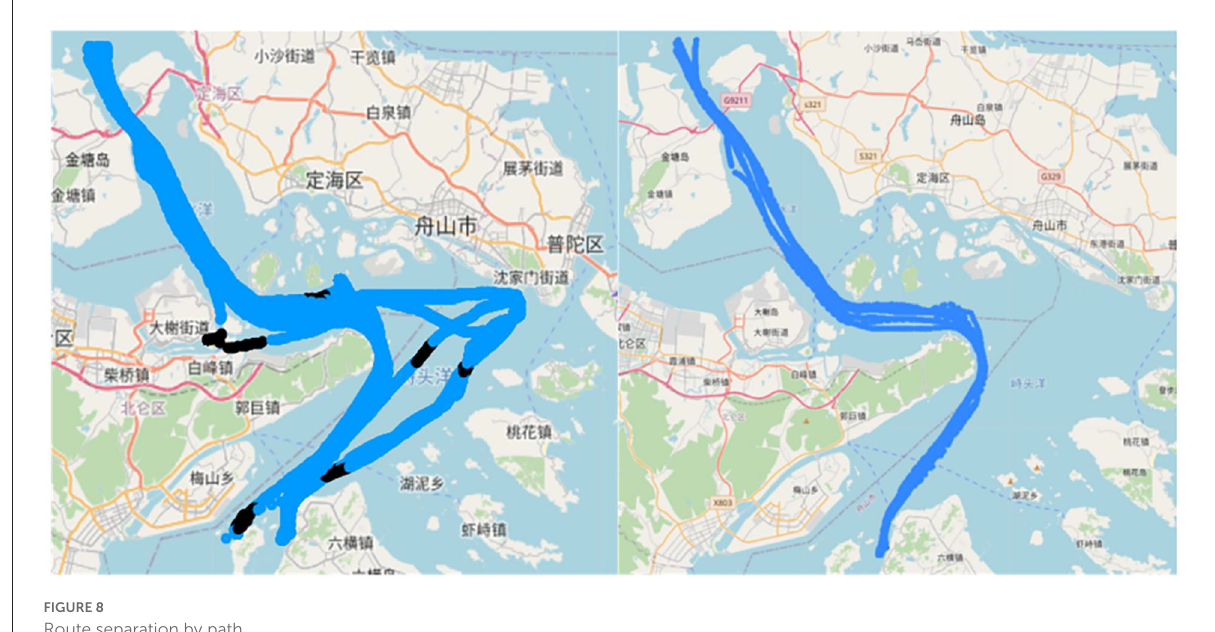
FIGURE8 Route separation by path.